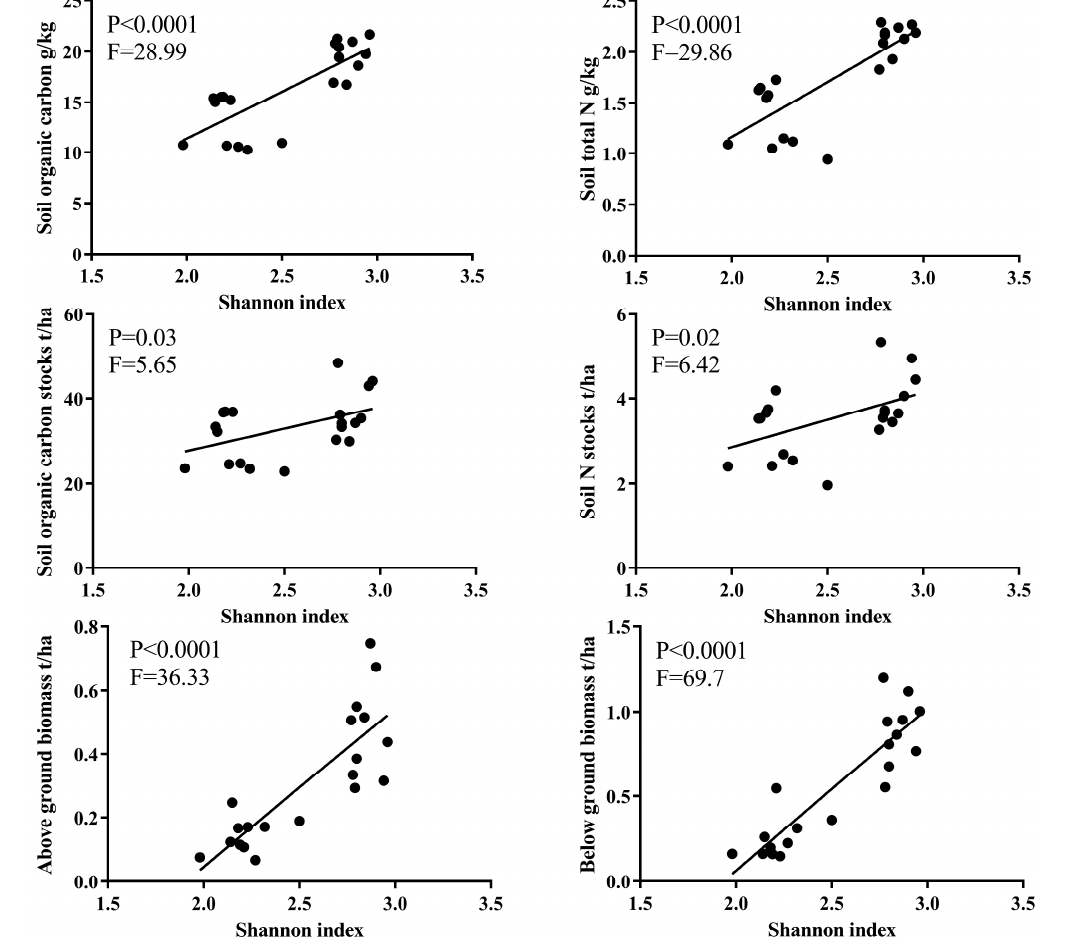
Figure 6. The regression between the Shannon index and SOC contents, TN contents, SOC stocks, TN stocks, AGB, and BGB.